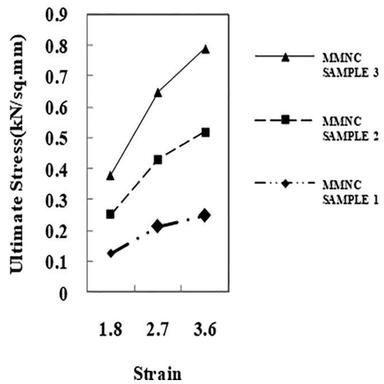
Compression Test Stress and Strain Analysis of MMNC Samples.